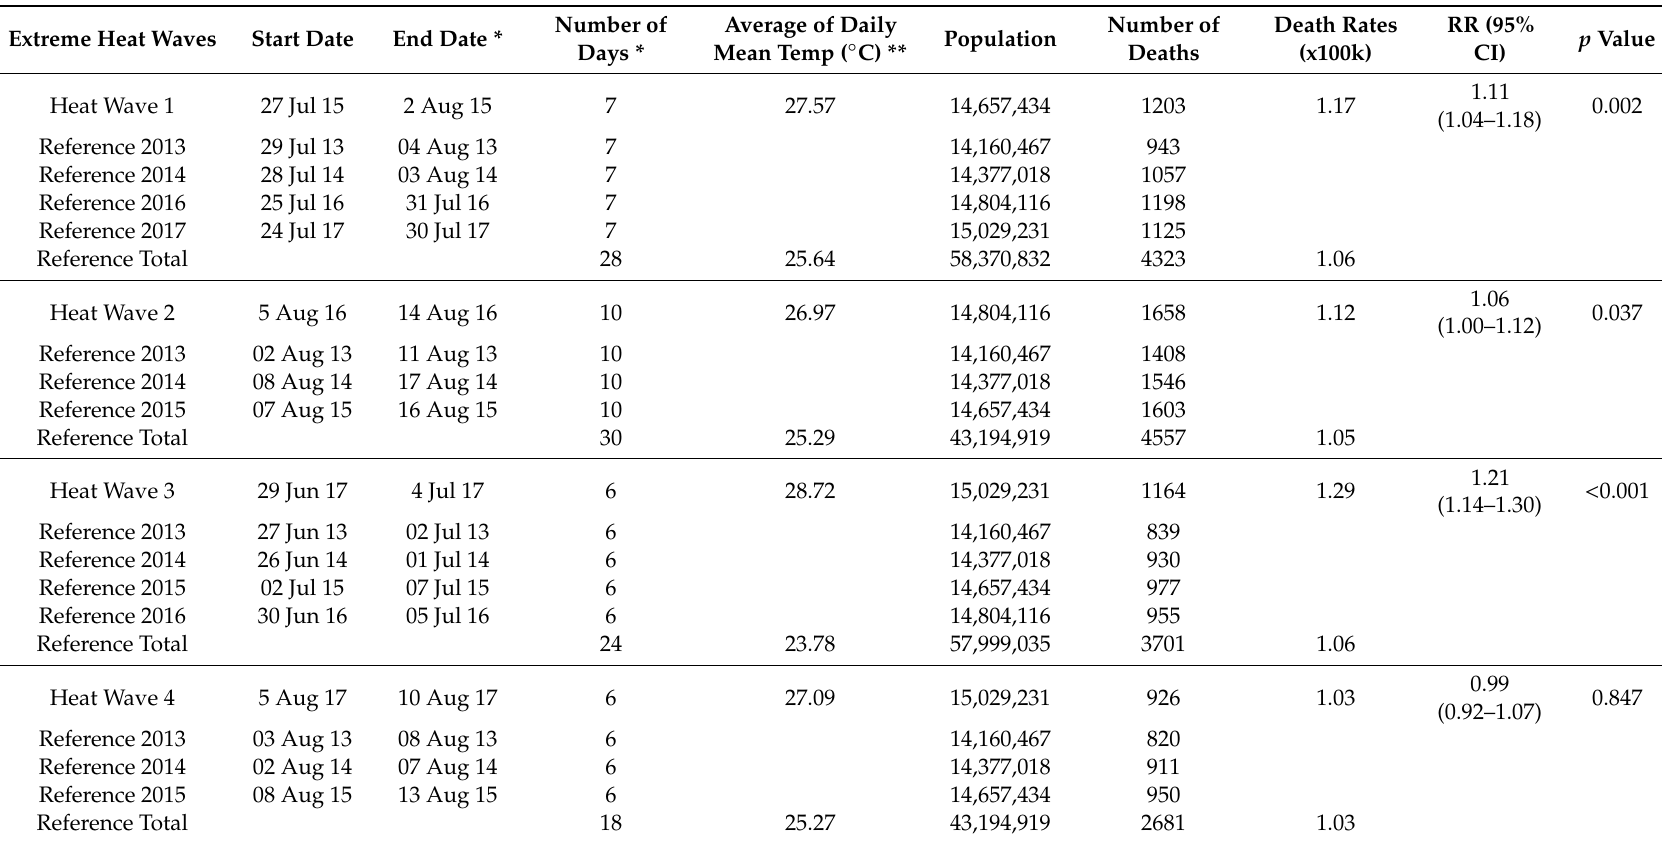
Table 2. Crude Death Rates and Risk Ratios (RR) of the Extreme Heat Waves between 2013 and 2017 (* including 3 days lag, ** excluding 3 days lag). Extreme Heat